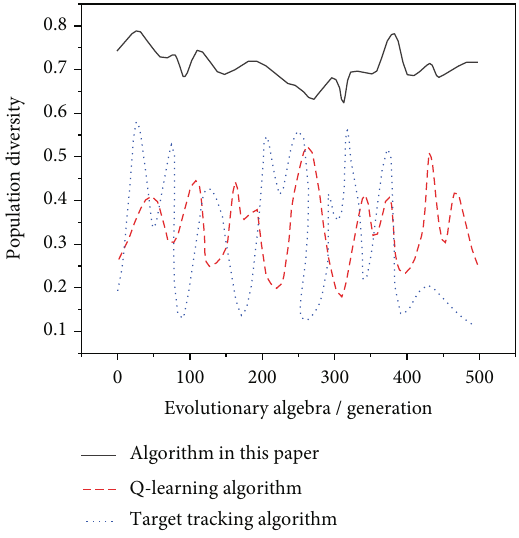
Figure 9: Diversity comparison of moving to